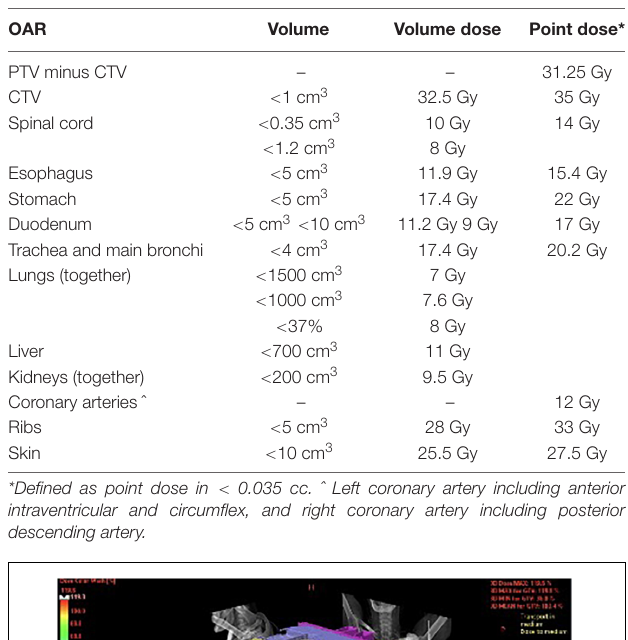
TABLE 1 | Dose constraints for organs-at-risks (OARs) and dose to